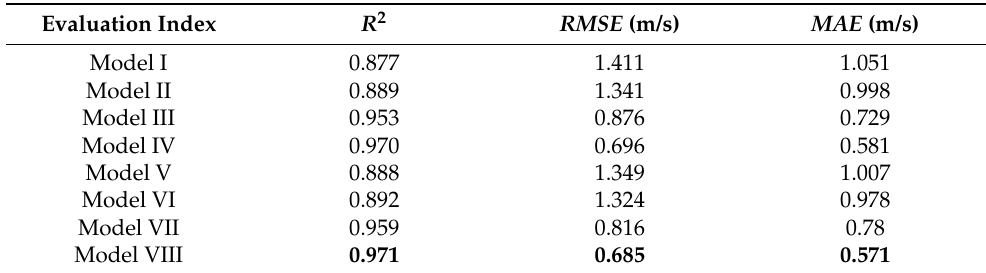
Table 5. Comparison of four model evaluation